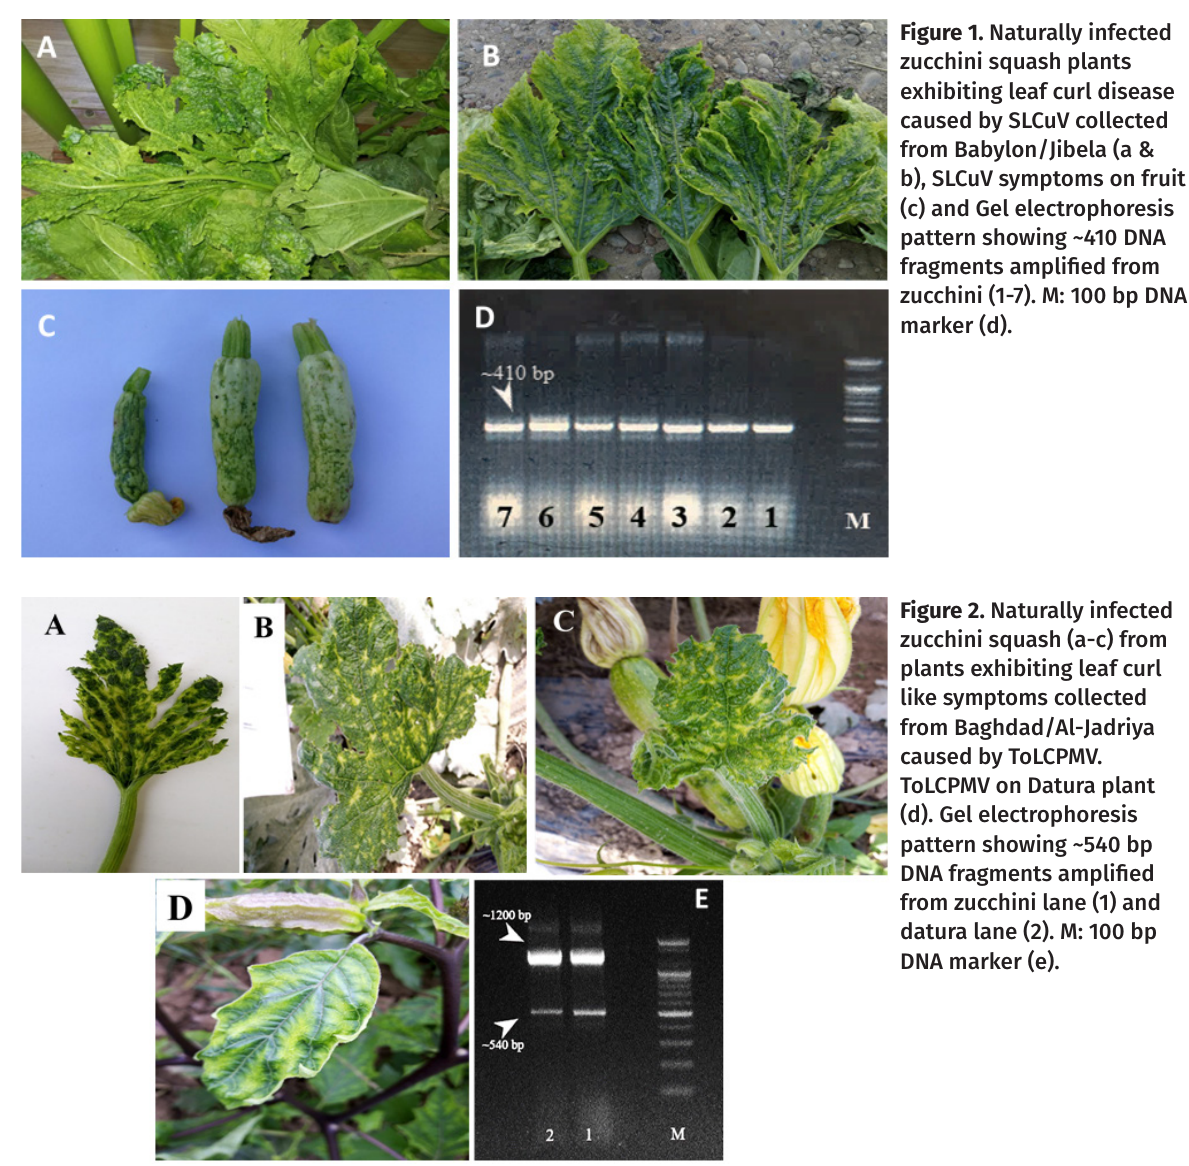
Figure 2. Naturally infected zucchini squash (a-c) from plants exhibiting leaf curl like symptoms collected from Baghdad/Al-Jadriya caused by ToLCPMV. ToLCPMV on Datura plant (d). Gel electrophoresis pattern showing ~540 bp DNA fragments amplified from zucchini lane (1) and datura lane (2). M: 100 bp DNA marker